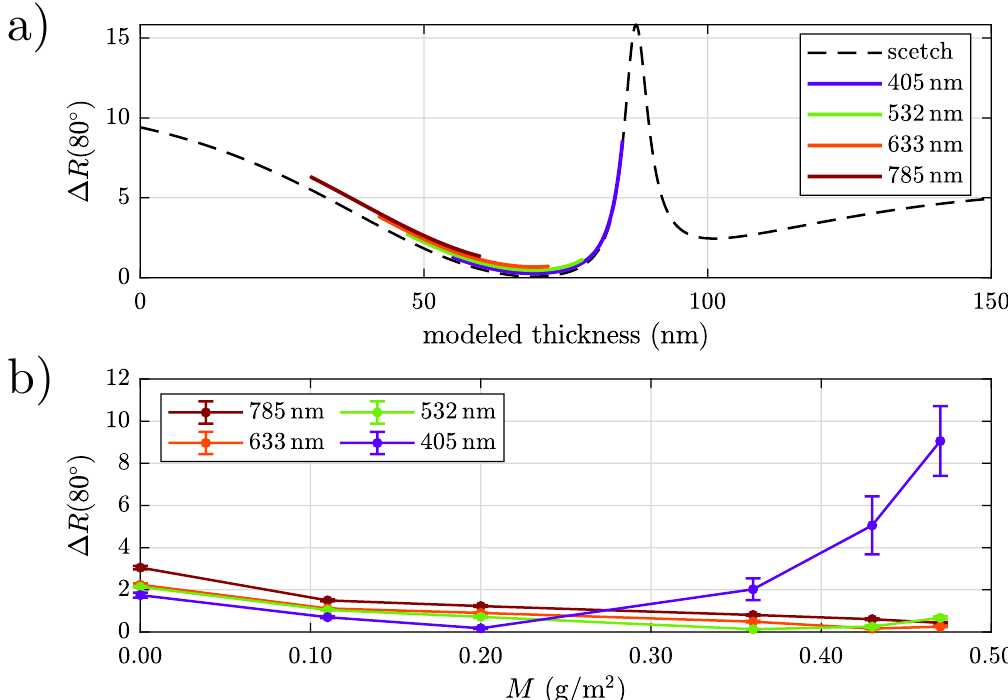
Figure 10. ∆ R ( 80 ◦ ) (black dotted curve) is calculated as a function of a modeled thickness in ( a ). In ( b ) the experimental results for our specimen using four different wavelengths are shown. The data fit well to the predicted behavior in